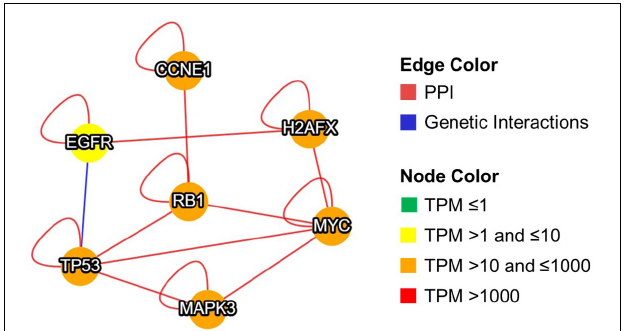
FIGURE 3 | Interaction between transcription regulators and kinases involved in telomere signaling and maintenance pathway in sperm after antioxidant treatment. Graphical representation of network developed using MIST. PPI: protein-protein interaction, TPM: transcripts per million, MYC: MYC proto-oncogene, CCNE1: cyclin E1, MAPK3: mitogen-activated protein kinase 3, TP53: tumor protein p53, RB1: RB transcriptional corepressor 1, H2AX/H2AFX: H2A.X variant histone, EGFR: epidermal growth factor